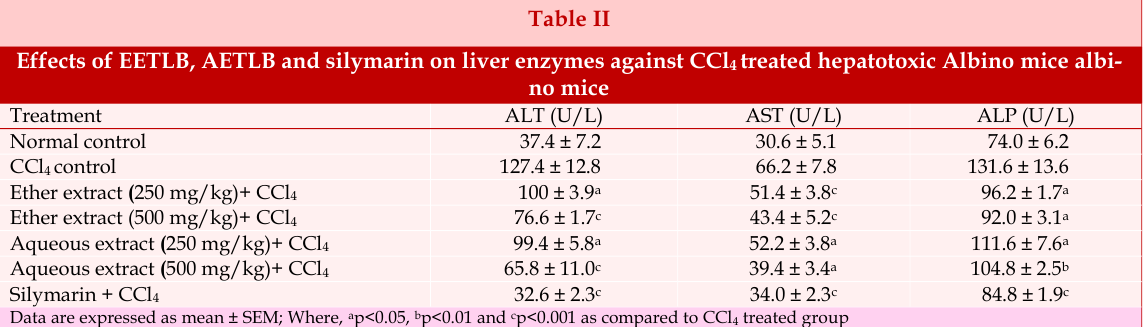
Effects of EETLB, AETLB and silymarin on liver enzymes against CCl 4 treated hepatotoxic Albino mice